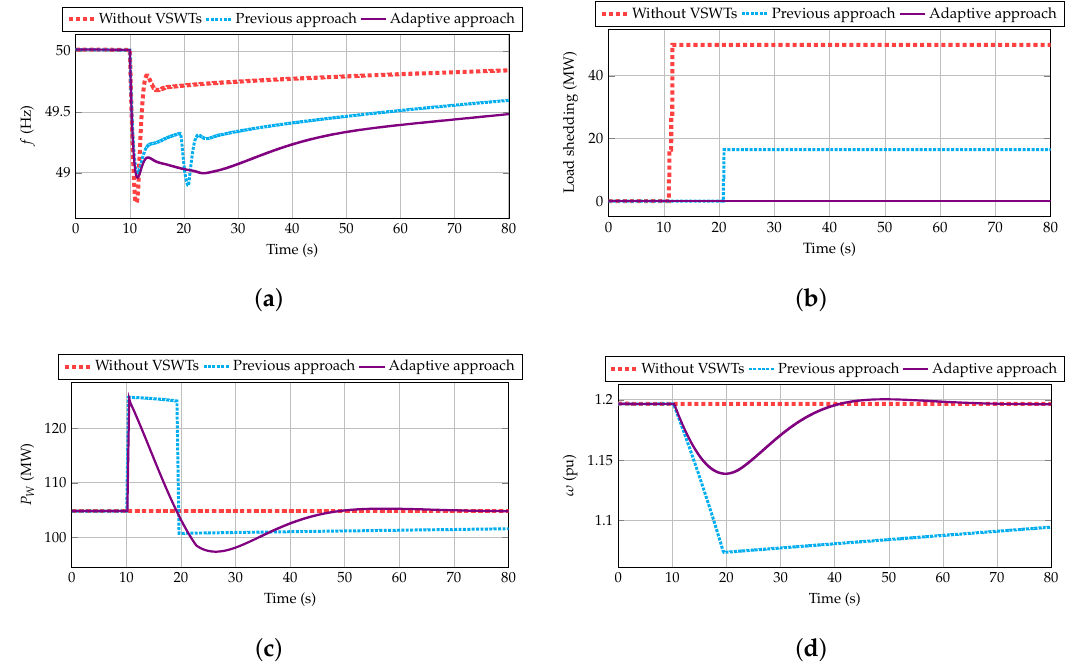
Figure 12. Results for scenario 9 ( a ) Frequency (Hz). ( b ) Load shedding (MW) ( c ) Wind power (MW) ( d ) VSWTs rotational speed (pu).